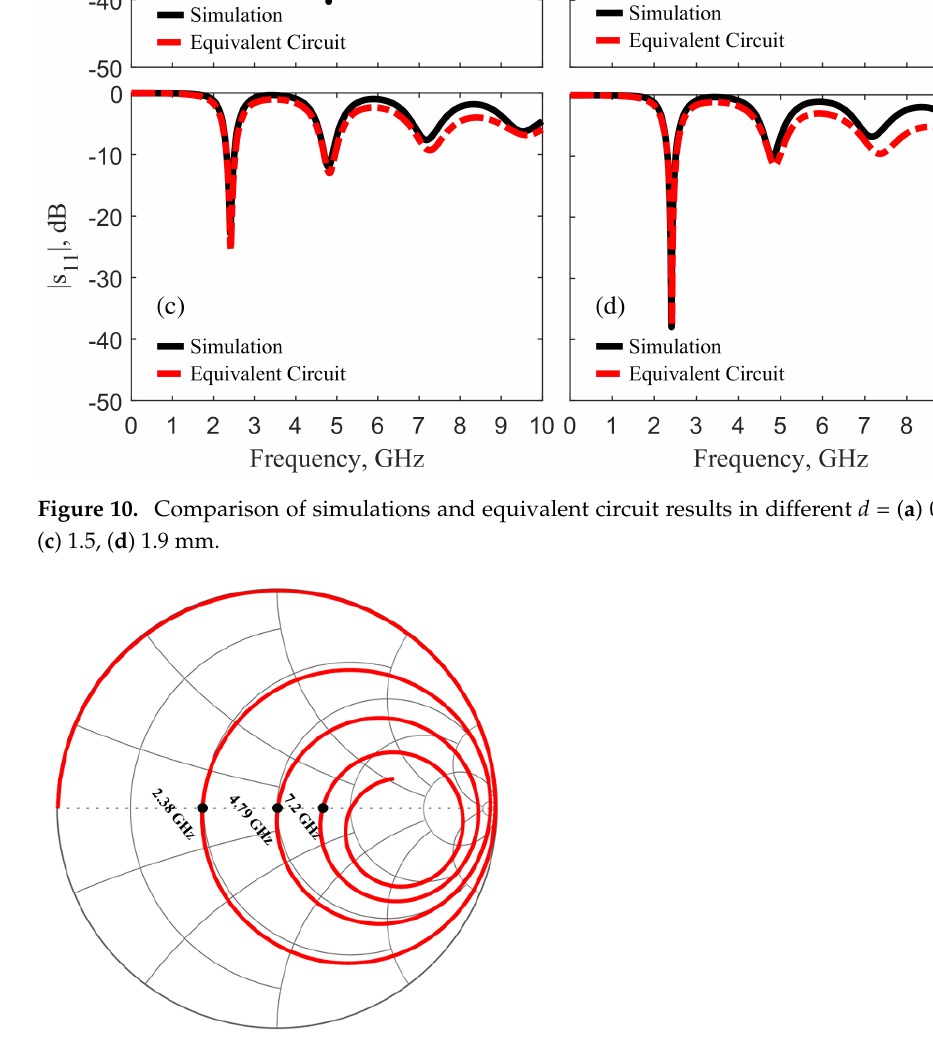
Figure 11. Reflection coefficient in the Smith chart for d = 0.5 mm from DC to 10 GHz within which it covers the first four orders of resonance. s 11 passes through the matching point at the 2nd resonant frequency of 4.79